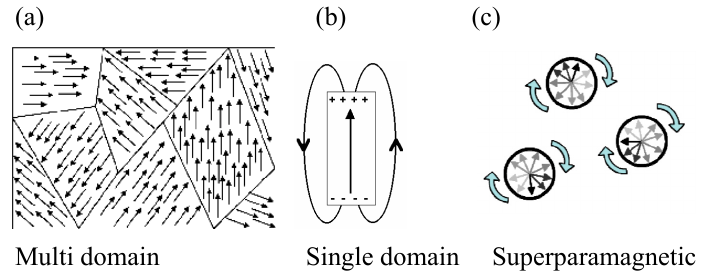
Figure 1. Magnetic behavior of a magnetic sample featuring ( a ) a multidomain structure, ( b ) a single-domain, and ( c ) superparamagnetic properties (adapted from [43]).